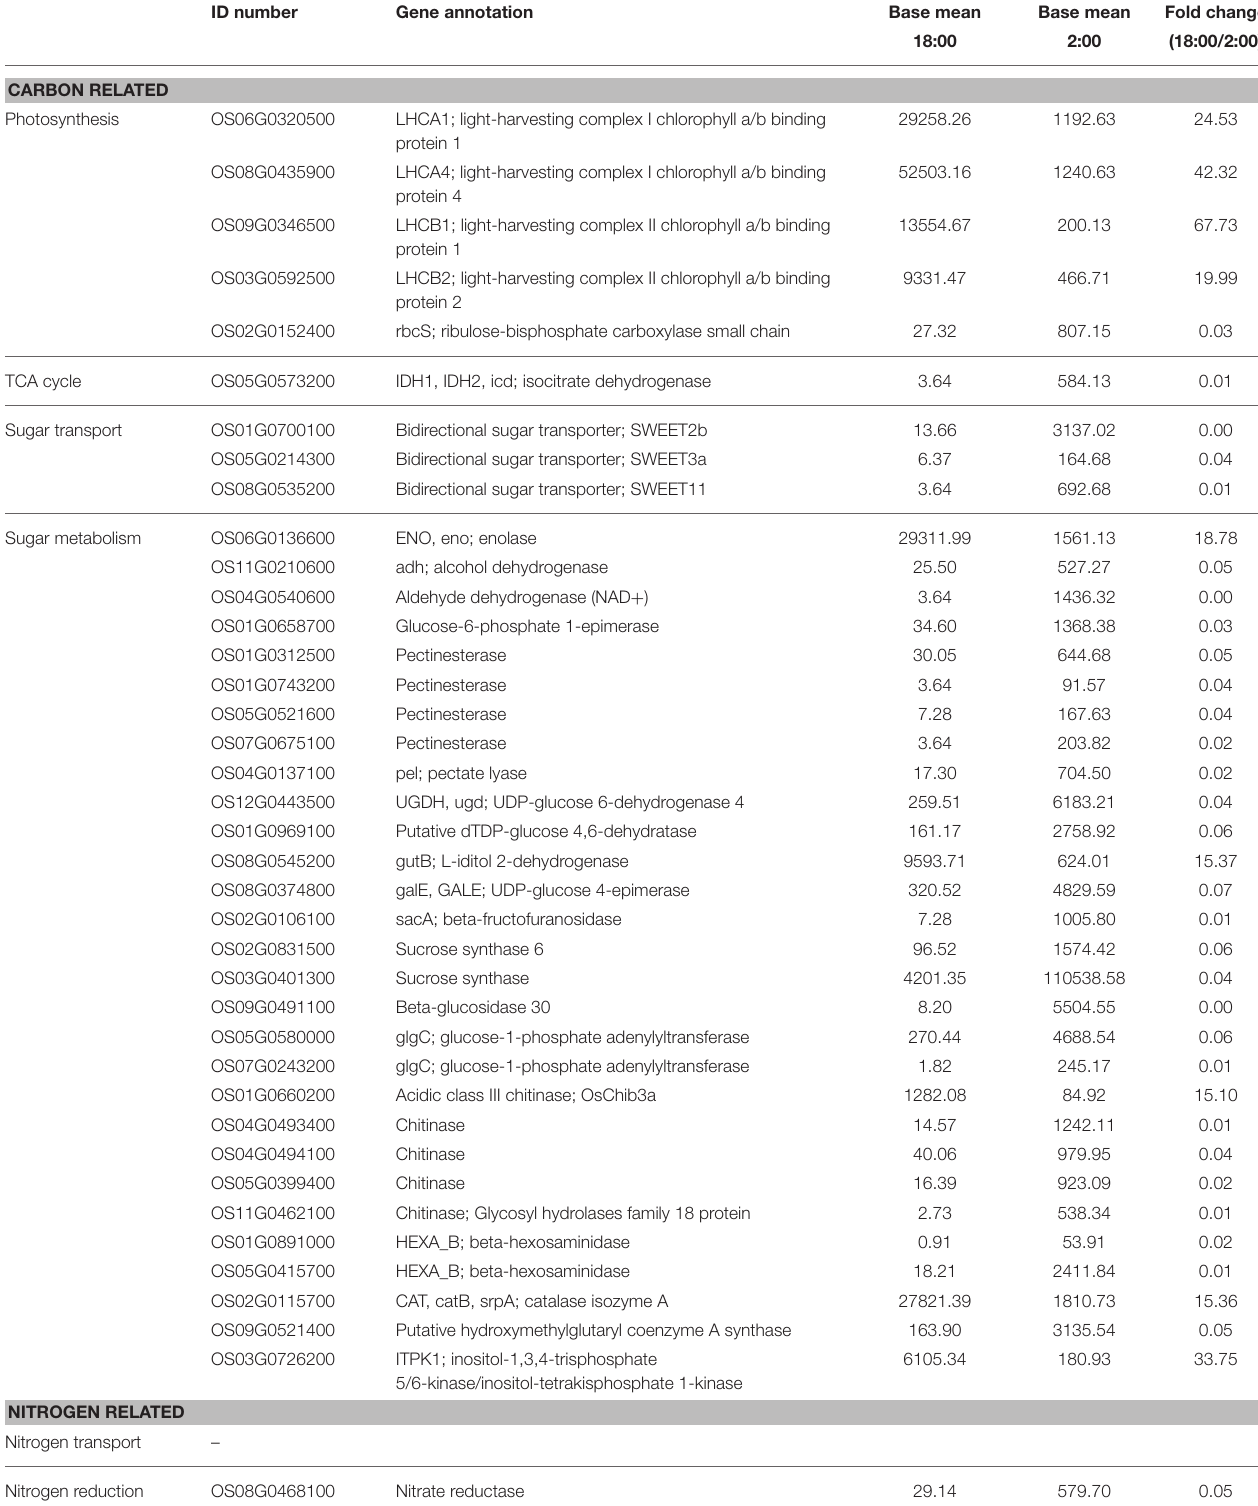
TABLE 4 | Differentially expressed genes involved in carbon and nitrogen metabolism at the time of 18:00 compared to